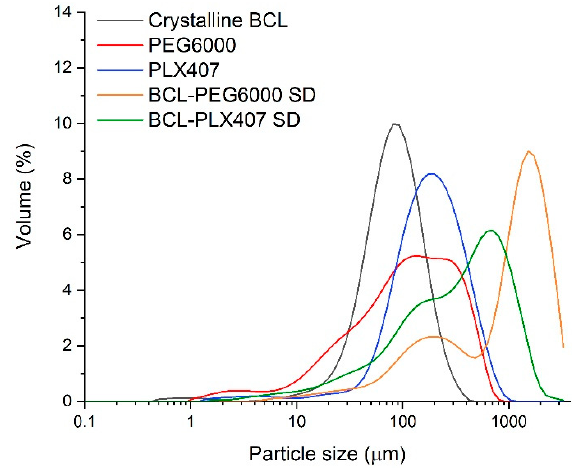
Figure 2. The particle size distribution of raw bicalutamide, polymers, and solid dispersions.